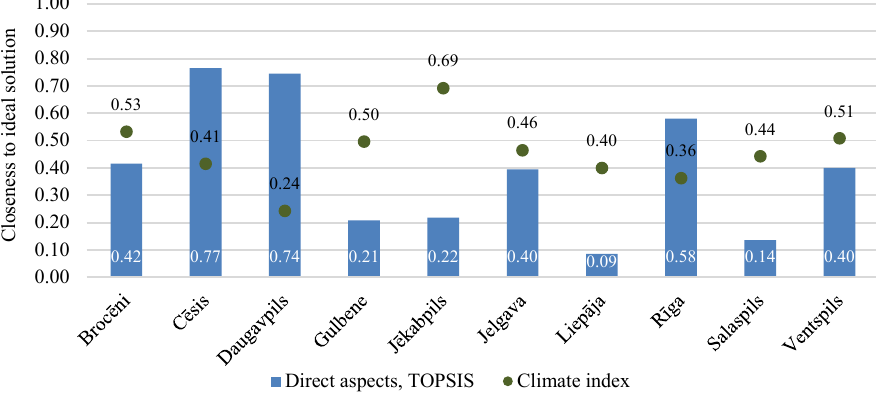
Fig. 5. Climate Index indicators and results of TOPSIS analyses for sustainable development